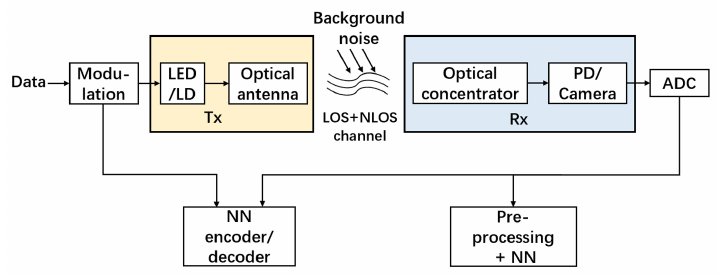
Figure 14. General applications of ML in indoor OWC